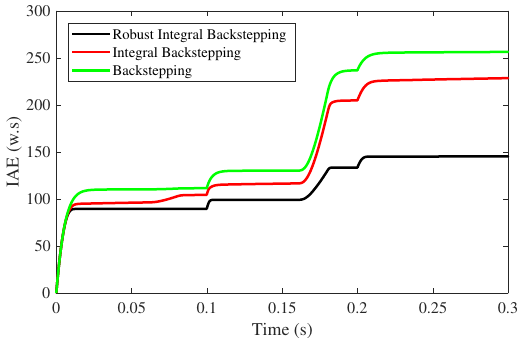
Figure 18. IAE for multiple faults under varying irradiance and temperature.